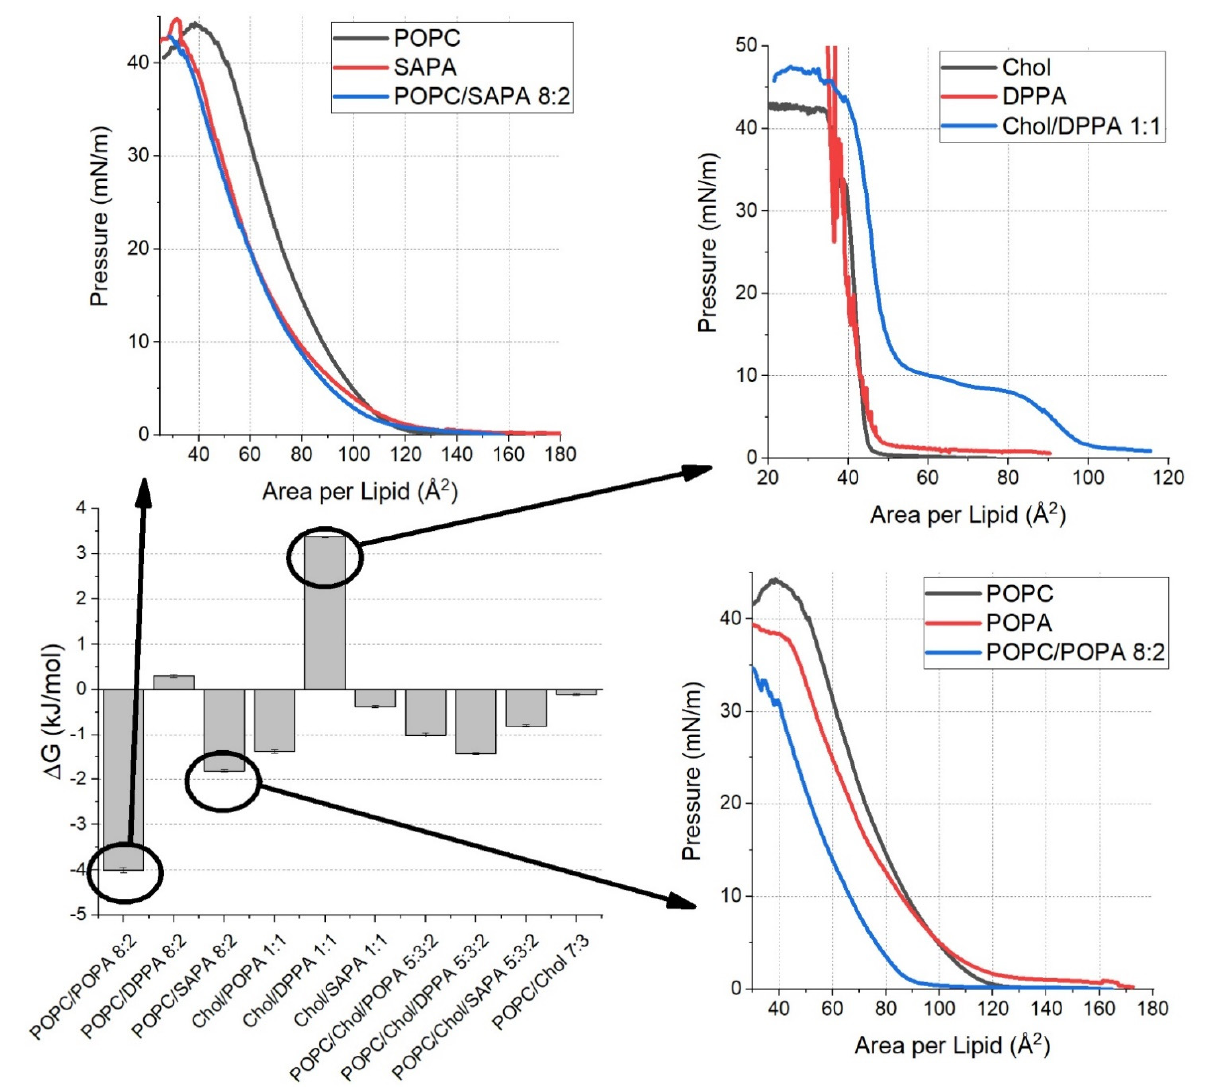
Figure 5. Excess free energy of mixing for investigated membrane systems with insets showing mixing of the most interesting two-component monolayers—POPC/POPA, POPC/SAPA, and Chol/DPPA. The rest of the mixing is presented in Supporting Information (Section